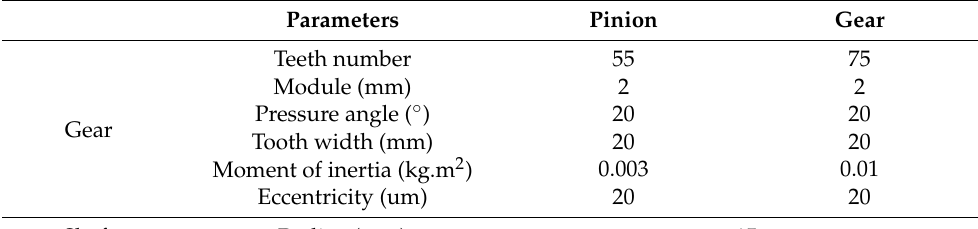
Table 1. Parameters of a gear system.